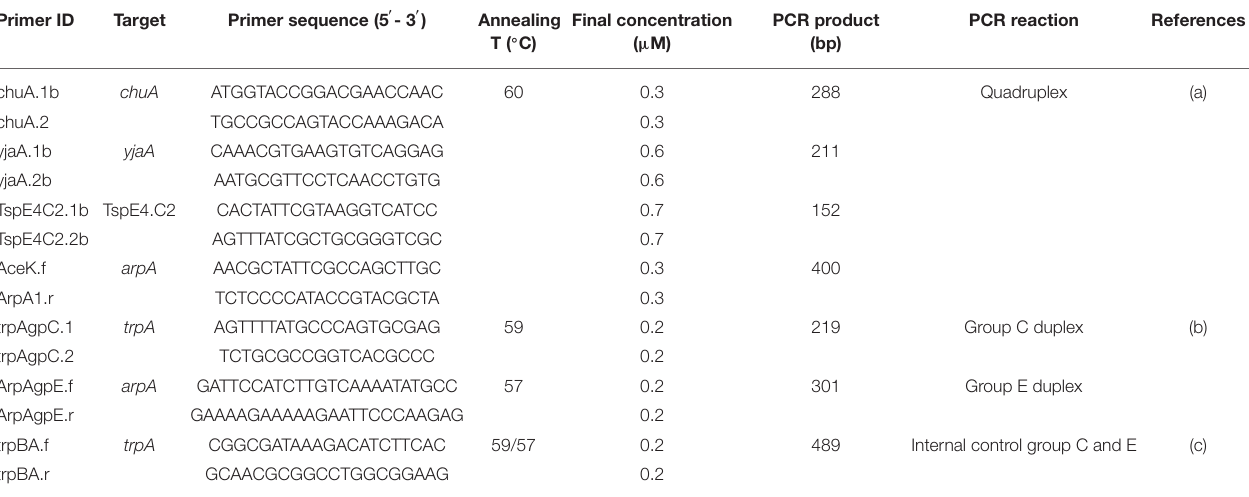
TABLE 2 | List of primers, target genes, primer sequences, annealing temperatures, and primer concentrations used for E. coli phylogenetic group typing in this study. Primer